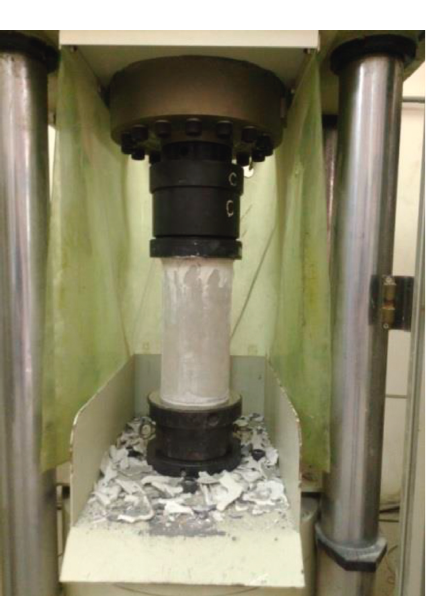
Figure 3: Concrete compressive strength